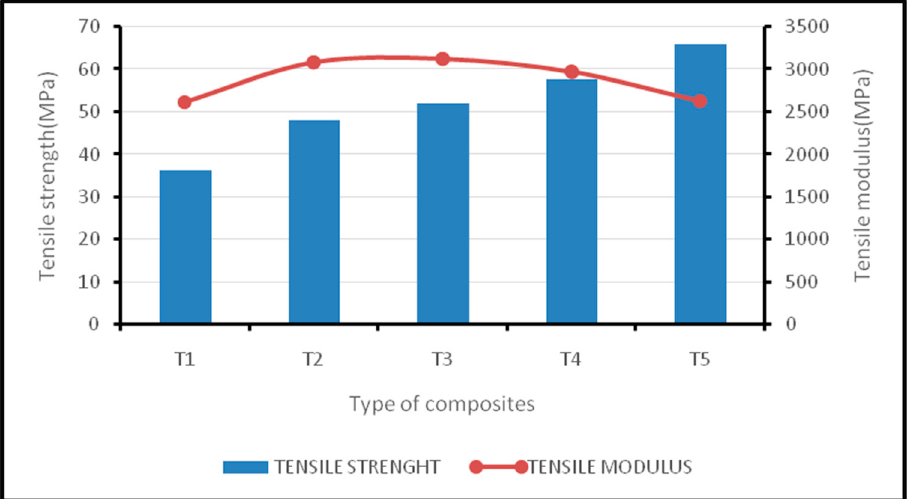
Figure 1. Tensile strength and modulus of oil palm EFB/woven kenaf fiber-reinforced epoxy-based bi-layer composites.